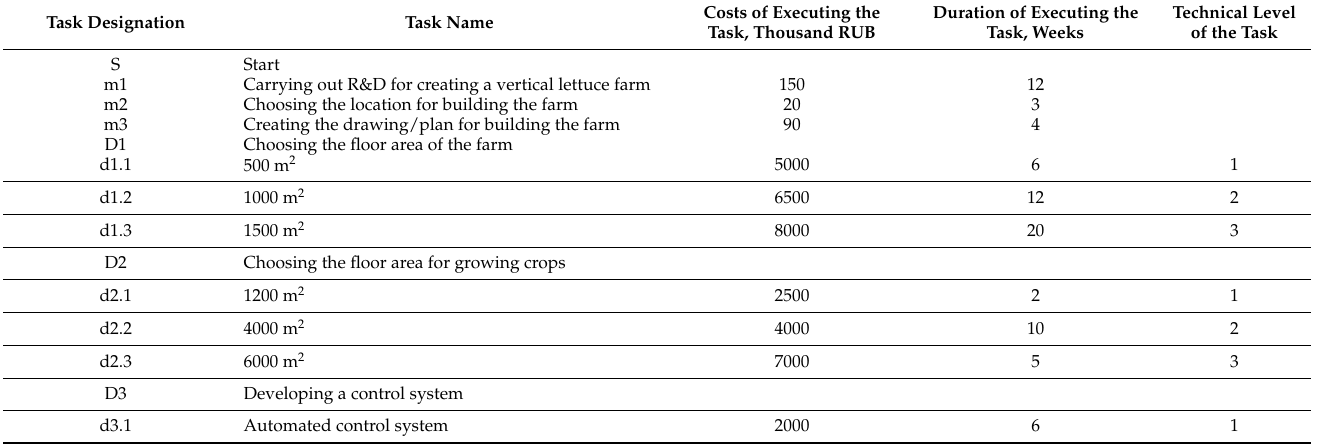
Table 6. The specification of project tasks of the alternative